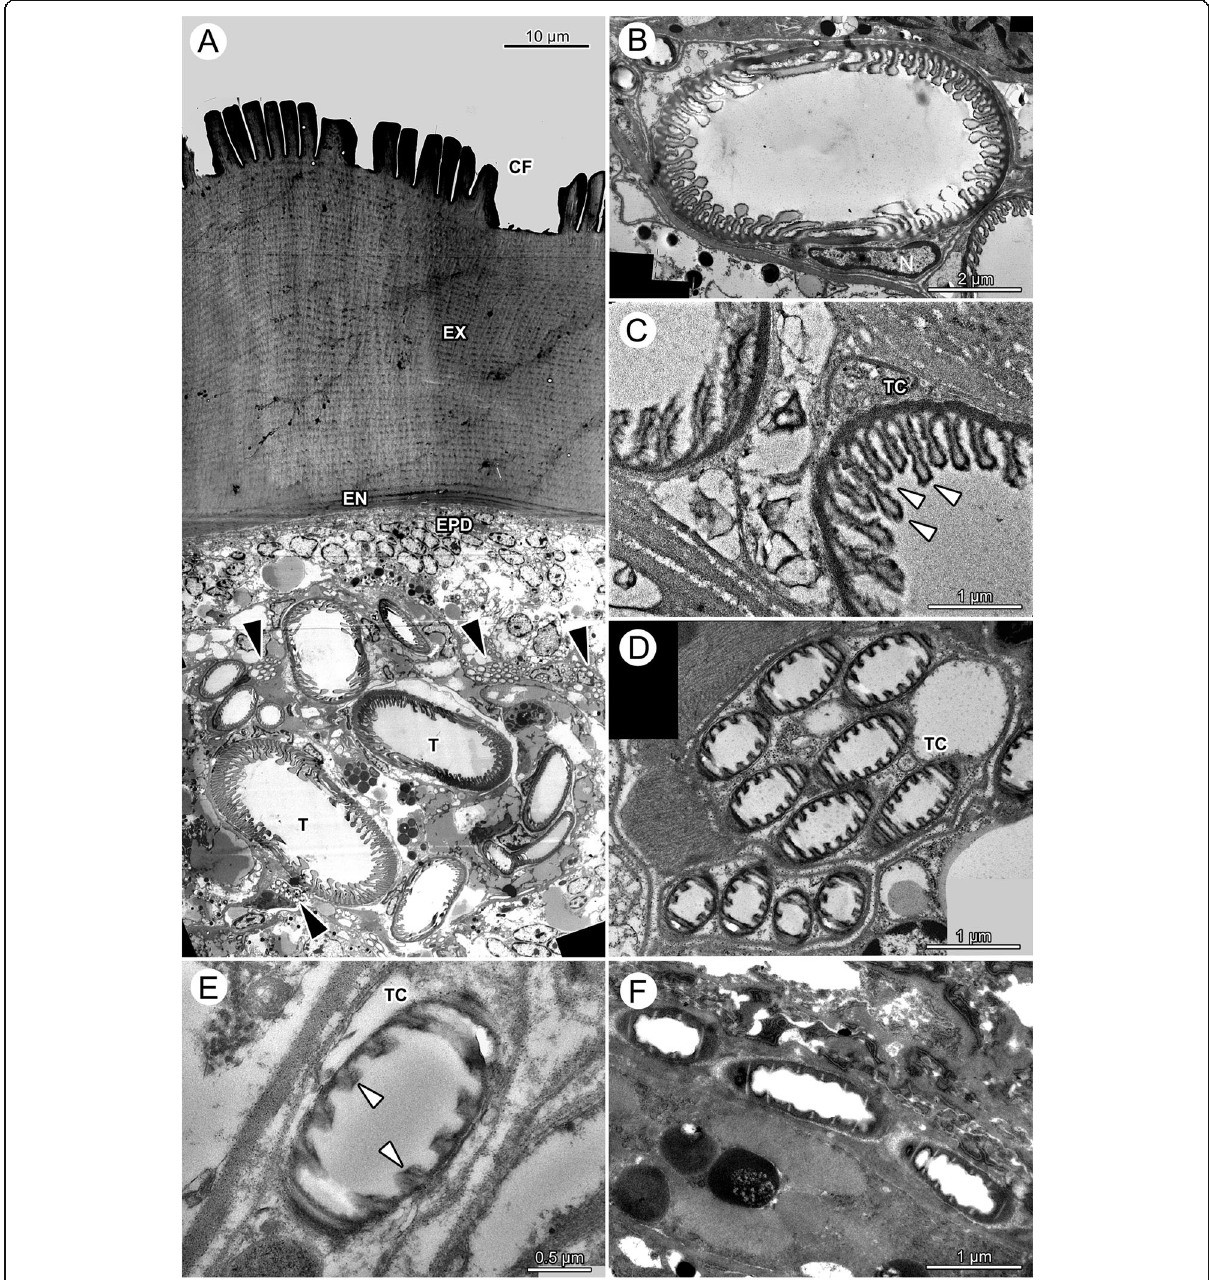
Fig. 7 Ixodes ricinus, TEM of tracheae and tracheoles. a Low-power, overview micrograph of larger and smaller tracheae of a fasting tick positioned directly under the cuticle. Note that the large tracheae reside in the hemolymphatic space while bundles of tracheoles are densely packed in tracheal cells and connected to other tissues. Arrowheads point to individual tracheae. b Cross section through a large trachea of a fasting tick. The inner cuticular lining of the tracheae forms taenidia of variable height and shape. In particular, the cross section of the larger taenidia is club shaped. c Detail of the taenidia of two neighboring tracheae of a fasting tick. The electron-dense epicuticle forms irregular surface extensions. d Cross-section through two bundles of tracheoles of a fasting tick, each bundle residing in its own tracheal cell. Tracheoles show regular taenidia. e High power magnification of a single tracheole in a fasting tick. f High power magnification of a single tracheole in a fully engorged tick. Note that the taenidia have disappeared suggesting stretching of the tracheoles. The electron-light core of the taenidia is still recognizable as light stripes, suggesting that it is mainly the intertaenidial region that stretches when ticks increase in volume. Abbreviations: CF, cuticular folds; EN, endocuticle; EPD epidermis; EX, exocuticle; N, nucleus of tracheal cell; T, trachea; TC, tracheal cell; black arrowhead, bundles of tracheoles; white arrowheads,